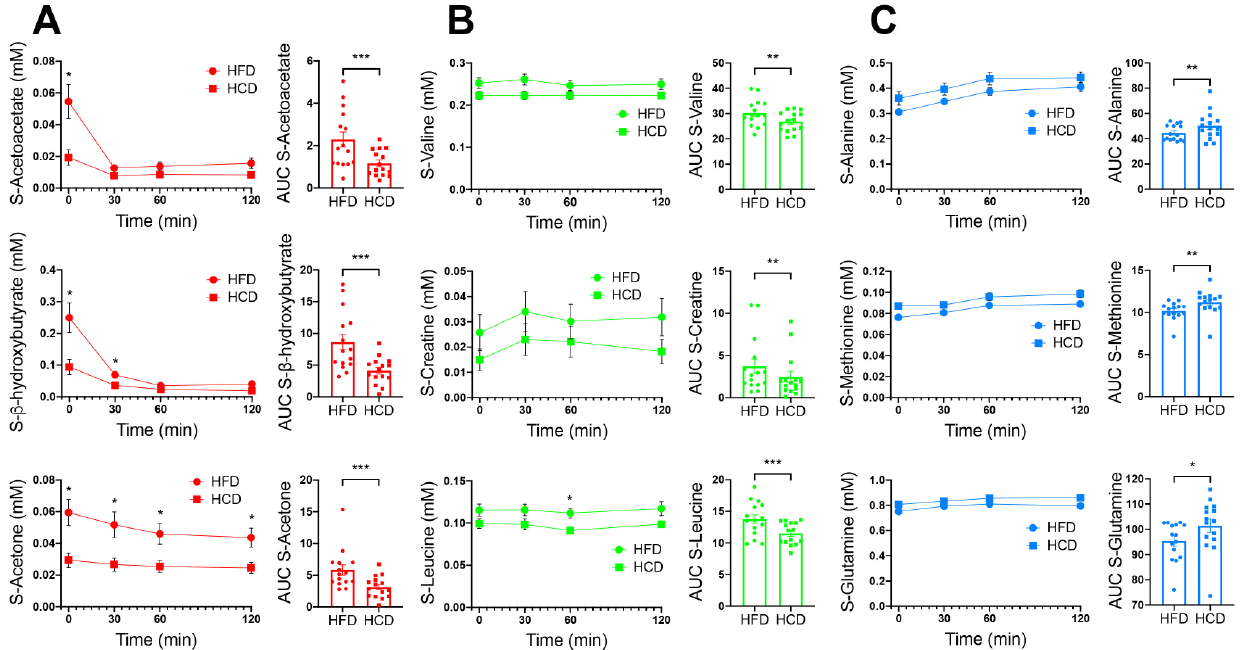
Figure 3. Serum levels of acetoacetate, β -hydroxybutyrate and acetone are shown in red ( A ), valine, creatine and leucine are shown in green ( B ) and alanine, methionine and glutamine are shown in blue ( C ); colors corresponding to the colors of metabolites in the OPLS-DA model in Figure 2), in normal-weight, healthy subjects after two weeks of HFD (circles) vs. HCD (squares), 0–120 min after an MMT. The MMT was ingested within the first 10 min starting at 0 min. * p < 0.05, using Sidak’s multiple comparison test. The area under the curve (AUC), presented on the right in each panel, for each individual was calculated from the time profile. * p < 0.05, ** p < 0.01, *** p < 0.001, using the Wilcoxon test.